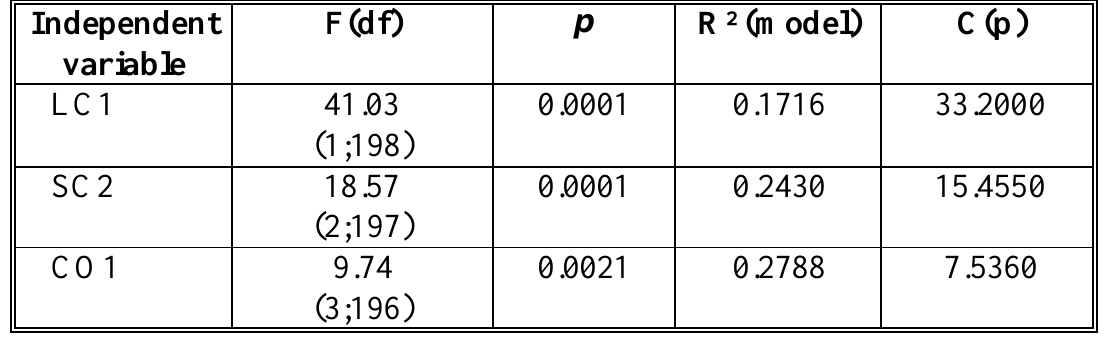
Table 12 Dependent variable: Entrepreneurial attitude 2: Achievement/